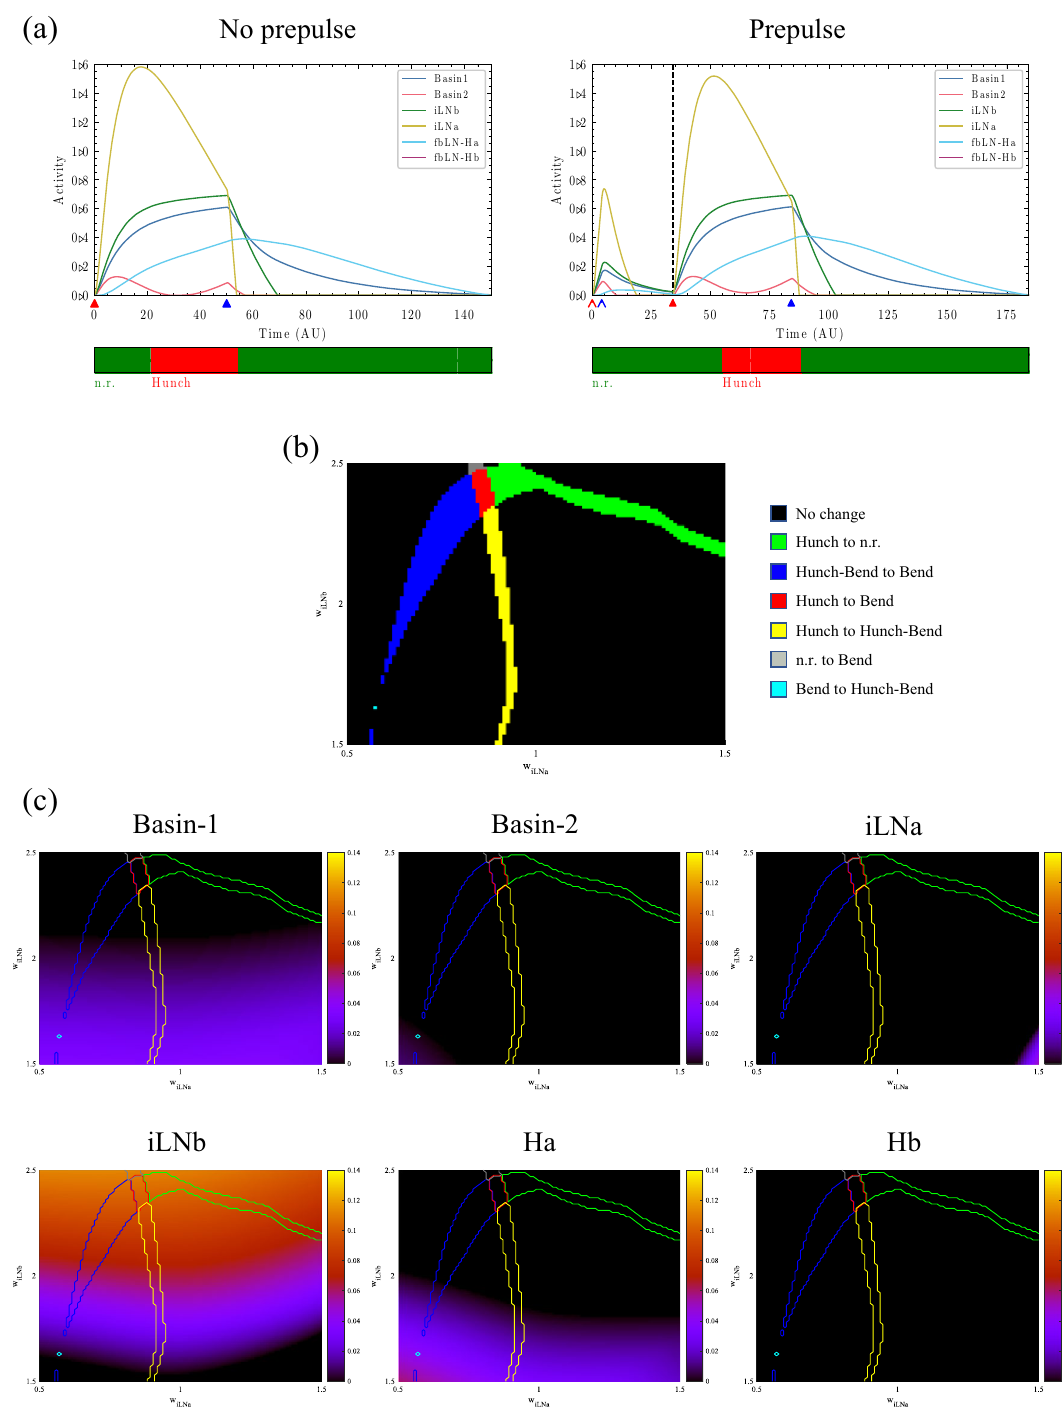
Figure 3. Relationship between PPI and cell activity. ( a ) Temporal changes in neuronal activity at the triangular dots shown in Fig. 2b ( w iLNa = 1.25, w iLNb = 1.75 ), where the startle response is not suppressed by a prepulse. Left: Without a prepulse; Right: With a prepulse. The vertical dashed black line indicates the time of the pulse input. The thin arrow head pointing to the horizontal axis indicates the prepulse timing, and the thick arrow head indicates the pulse timing. The red and blue colours indicate the onset and offset times, respectively. The colours in the band below each graph indicate the behaviour at the corresponding time. Green: n.r., red: hunch, blue: bend. ( b ) The behavioural landscape of behaviours in the w iLNb − w iLNa space. Each colour indicates how the behaviour changed with and without a prepulse input. Black: no change. Red: hunch to n.r. Blue: hunch- bend sequence to bend. Red: hunch to bend. Yellow: hunch to hunch-bend sequence. Grey: n.r. to bend. Cyan: bend to hunch-bend sequence. ( c ) Persistence of each neuronal activity induced by a prepulse at the time of a pulse input as a w iLNb − w iLNa spatial distribution. Each line indicates the boundary of behavioural changes due to PPI in ( b ). Orange colour indicates greater persistence of